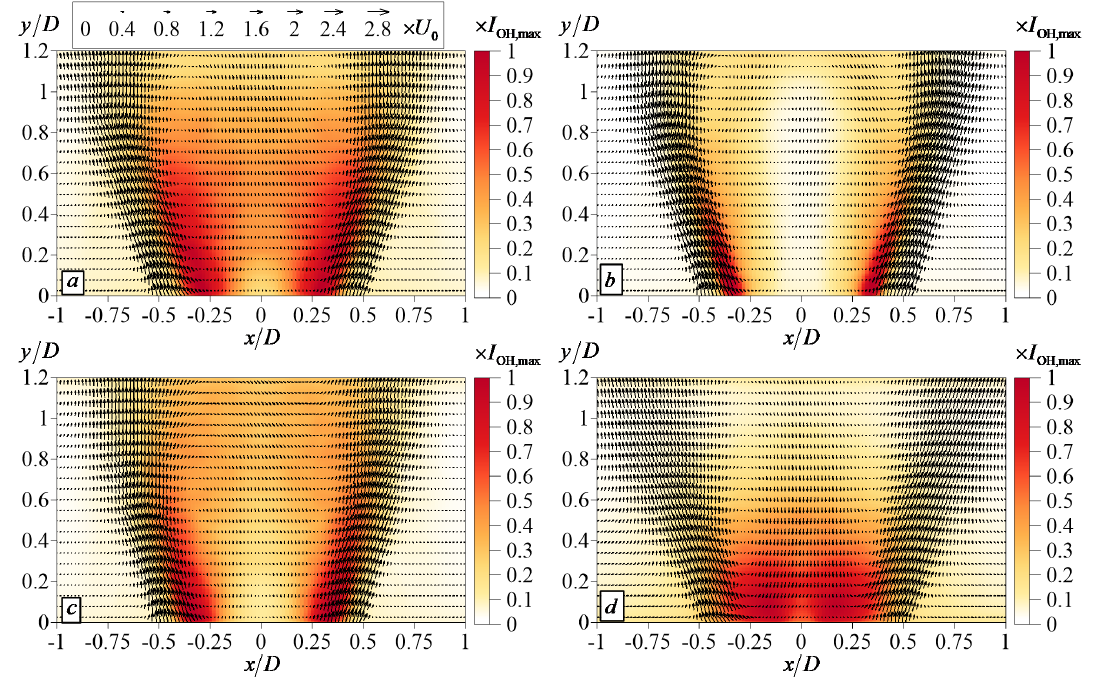
Figure 2. Time-averaged velocity field and OH PLIF signal for methane ( a , c ) and syngas ( b , d ) flames at normal conditions ( a , b ) and elevated pressure and temperature ( c , d ).